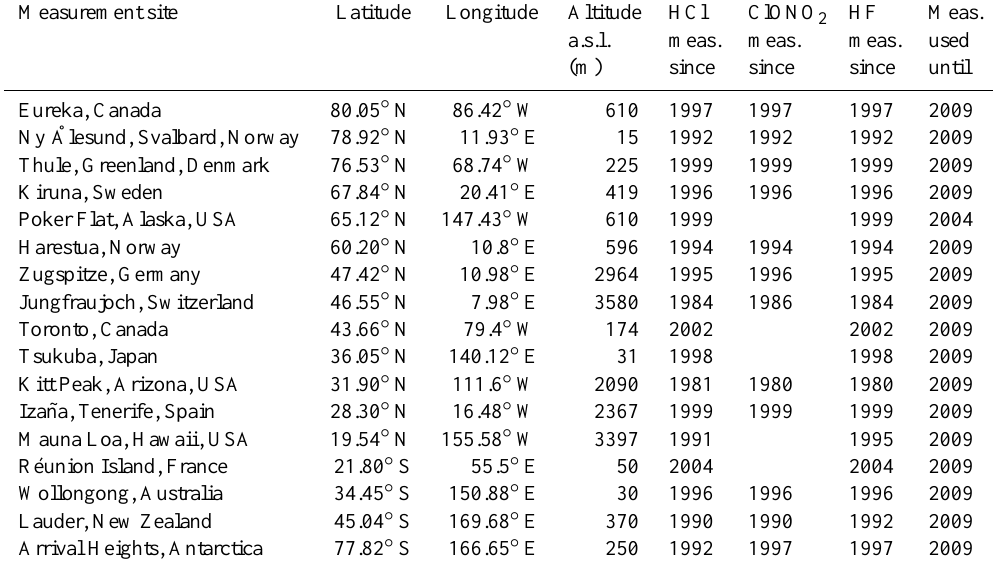
Table 1. Overview of the geographical coordinates of the 17 sites and the time ranges covered by the HCl, ClONO 2 , and HF measurements. Measurement